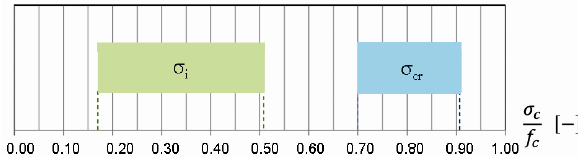
Fig. 2. Ranges of levels of cracking initiating stress σ i and criti- cal stress σ cr in ordinary concretes subjected to various techno- logical and nonmechanical service